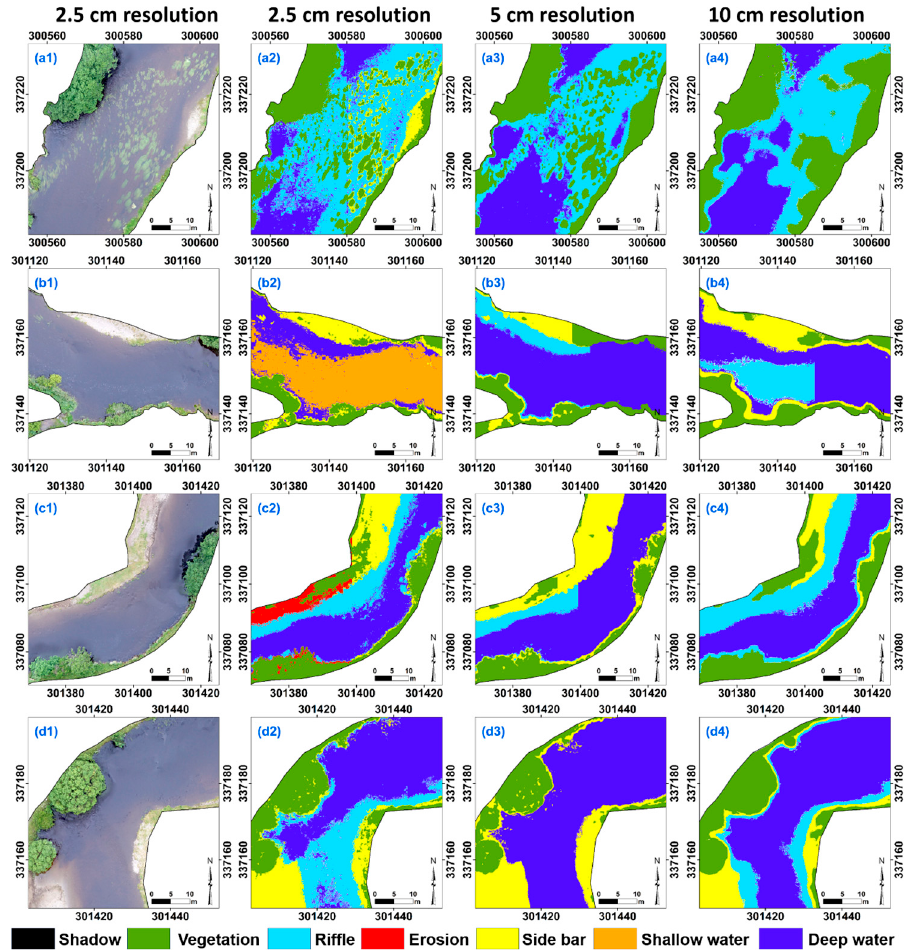
Figure 4. Detailed view of the feature classification obtained with LAIC for four sections within the 1.4 km reach for each of the resolutions: ( a1 – a4 ) detailed view of a section with submerged vegetation; ( b1 – b4 ) detailed view of a section with riffles; ( c1 – c4 ) detailed view of a section with erosion; and ( d1 – d4 ) detailed view of a section with side bars. The images on the left show the orthoimage at 2.5 cm resolution.